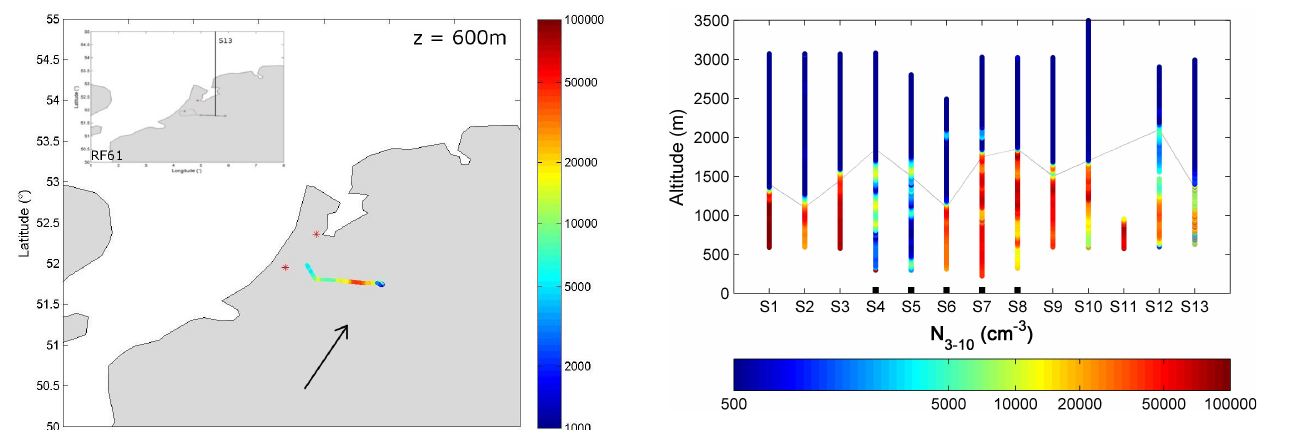
Fig. 7. Profile of the particle concentrations within the size range of 3-10nm during the ATR-42 soundings for the six flights when NPF events were observed: RF43 (S1, S2, S3, S4, S5, S6) on 05 May, RF45 (S7, S8) on 08 May, RF48 (S9) on 11 May, RF50 (S10) on 14 May, RF53 (S11) on 18 May, RF54 (S12) on 18 May, and RF61 (S13) on 28 May 2008. The black rectangles highlight soundings performed above the sea. The grey line corresponds to the top of the BL as described in Table